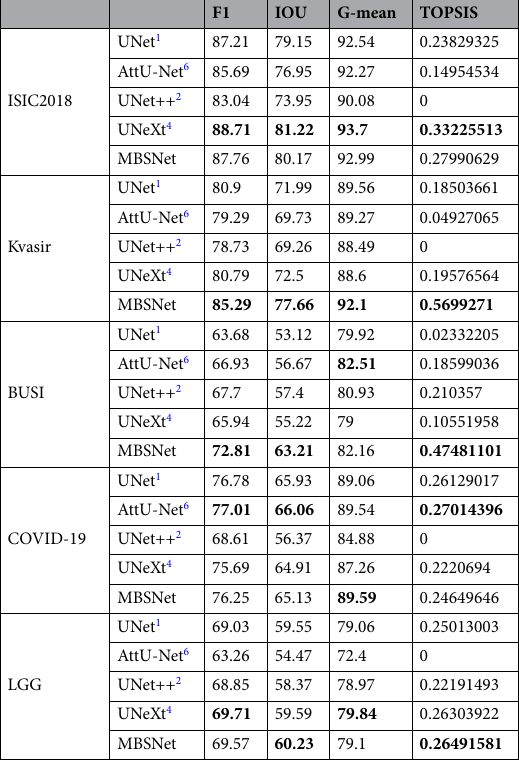
Table 1. Quantitative comparison of MBSNet with other models on ISIC2018 dataset, Kvasir dataset, BUSI dataset, COVID-19 dataset, and LGG dataset. Significant values are in [bold].